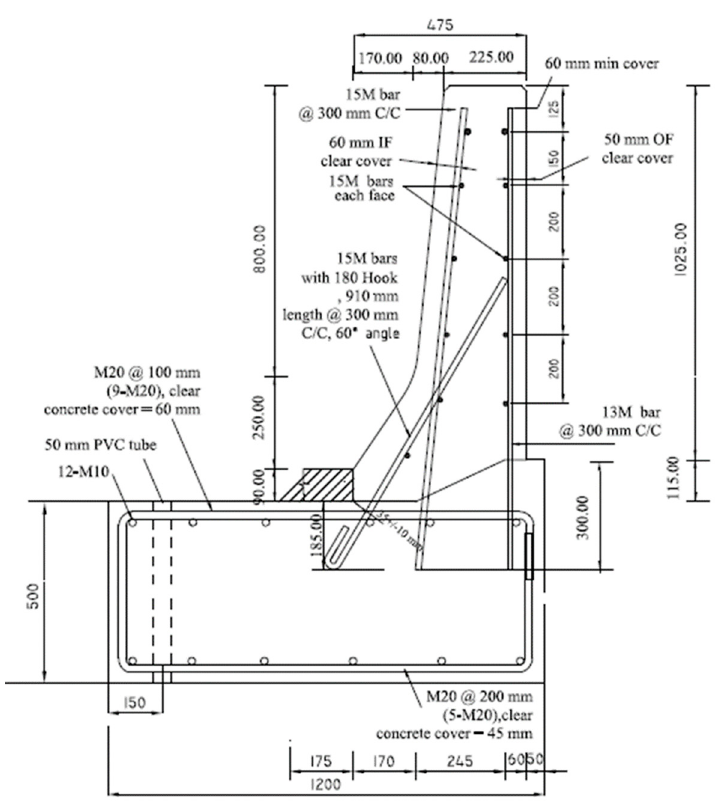
Figure 6. Specimen # 4: Interior location of barrier connected to a non-deformable slab.